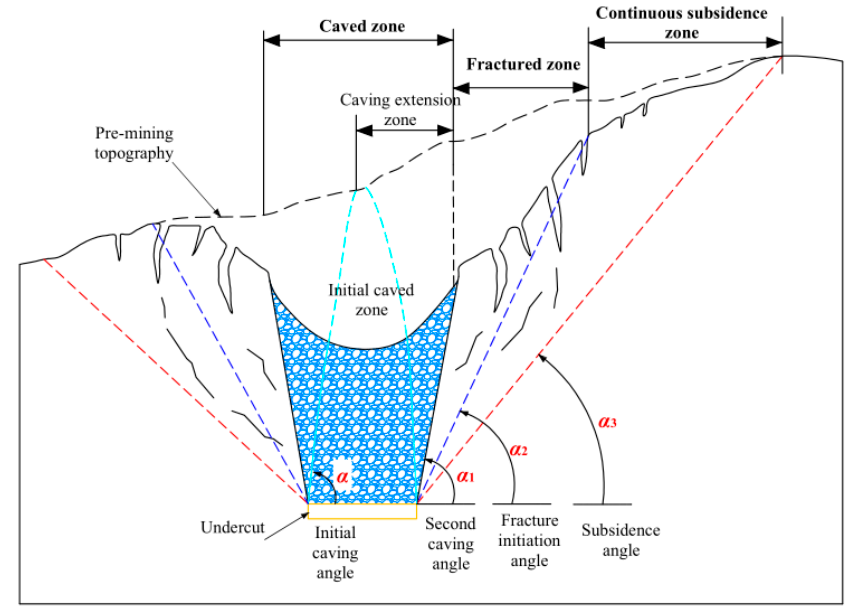
Figure 3. De fi nition of the surface in fl uence area caused by caving mining. Figure 3. Definition of the surface influence area caused by caving